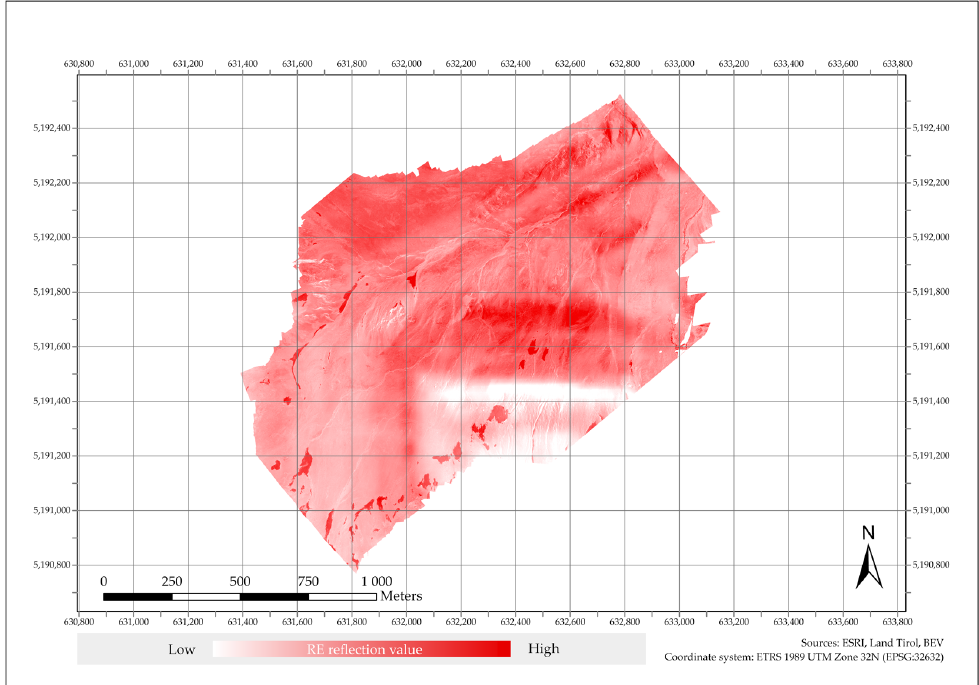
Figure 3. Varying illumination conditions are clearly visible on the RE orthomosaic.